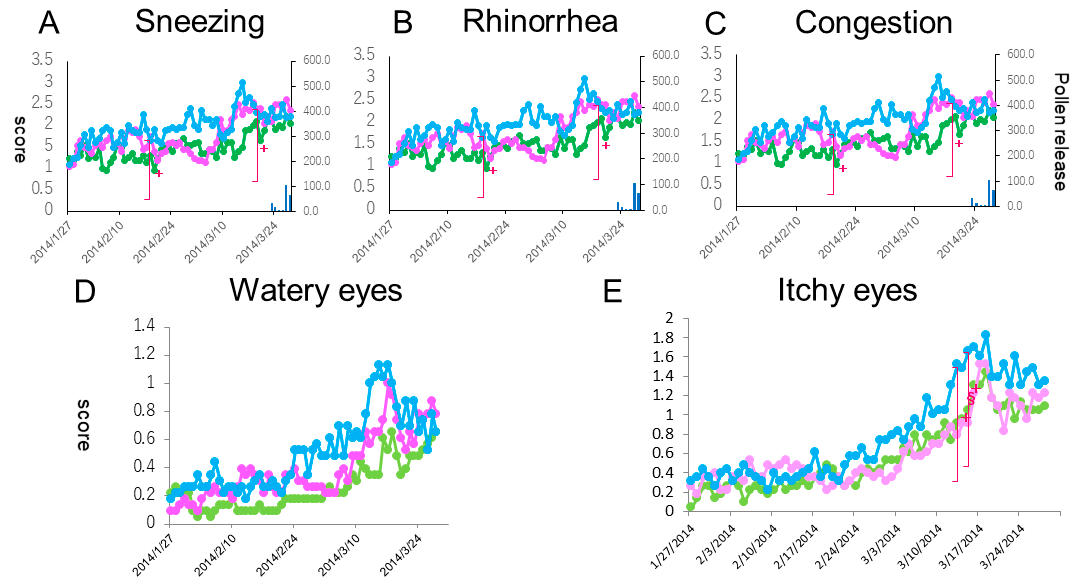
Figure 5. Daily scores reflective of sneezing ( A ), rhinorrhea ( B ), nasal congestion ( C ), watery eyes ( D ) and itchy eyes ( E ) from baseline. The lines, symbols and bars are explained in Figure 1. +: p < 0.05 (Kraskal-Walis test); *: p < 0.05 (A vs. B); #: p < 0.05 (A vs. C); § : p < 0.05 (B vs. C (Boferoni/Dunn test)).